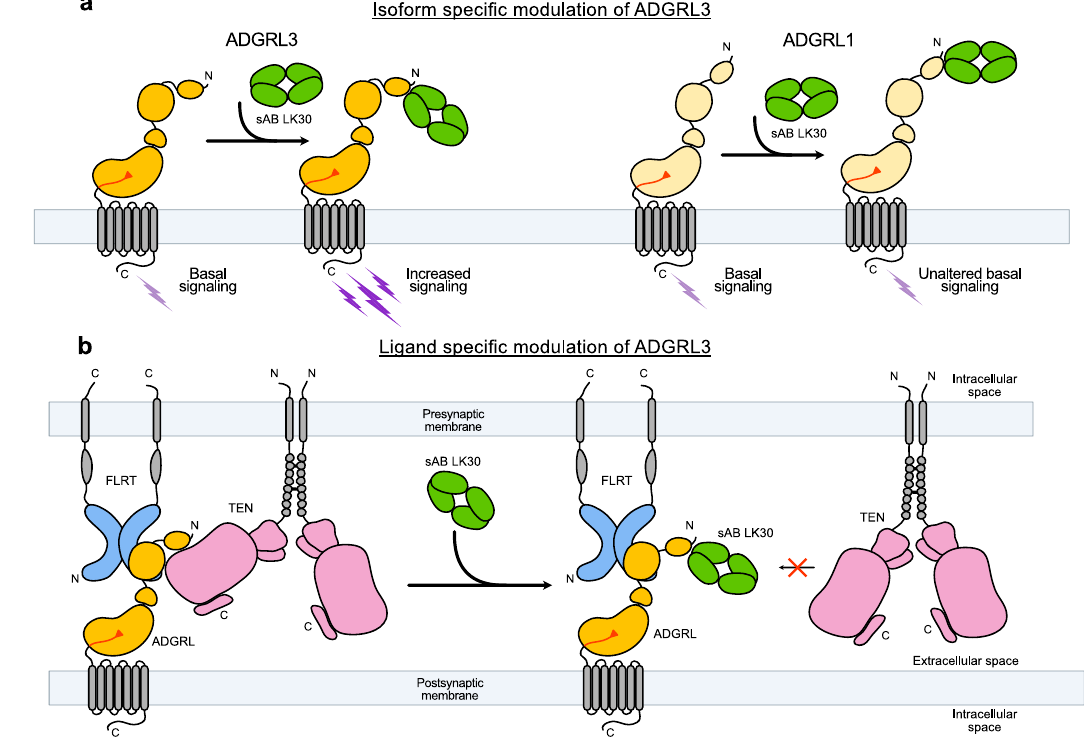
Fig.6|LK30modulatesADGRL3inanisoform-andligand-dependentmanner. a BindingofLK30toADGRLsmodulatesthereceptoractivityinanisoform-speci fi c manner. ADGRL3 (dark yellow) basal signaling increases upon binding of LK30 to theLecdomainofthereceptor.TheinteractionofLK30withADGRL1(lightyellow)